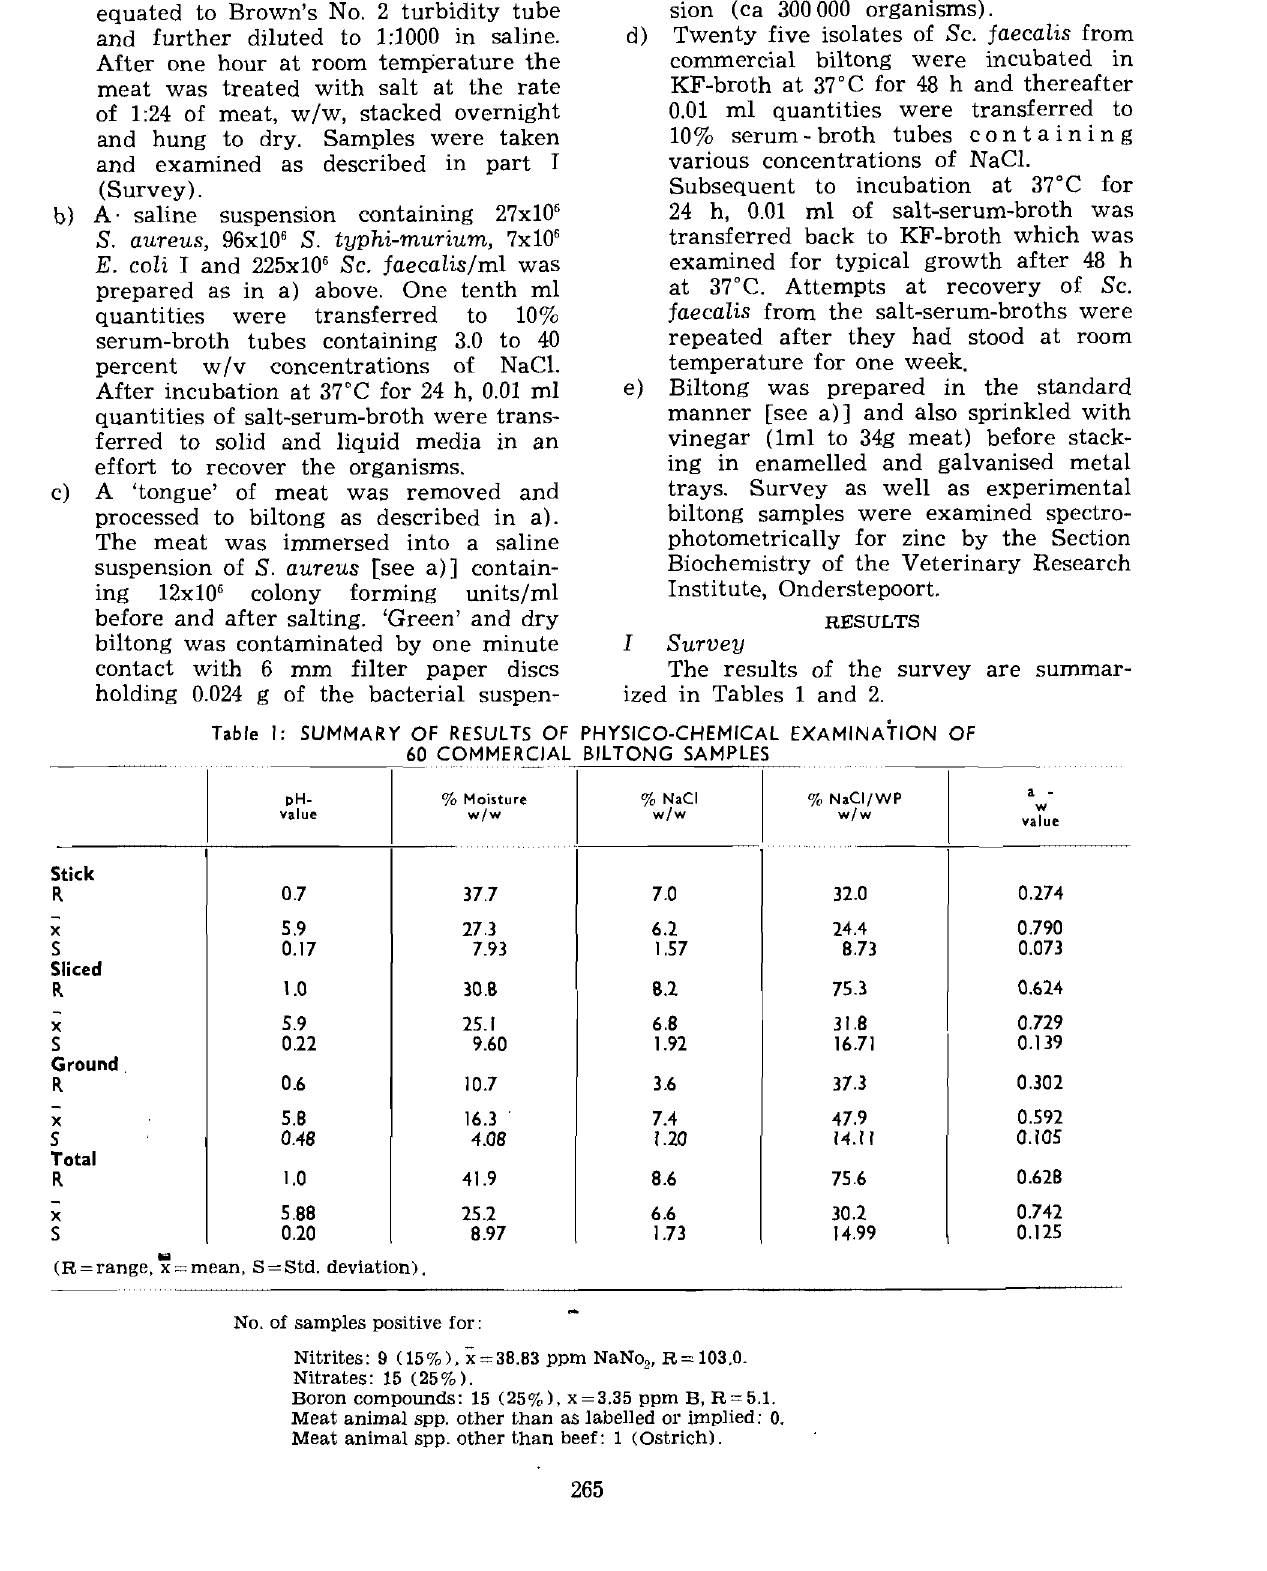
Table I: SUMMARY OF RESULTS OF PHYSICO-CHEMICAL EXAMINATION OF 60 COMMERCIAL BIL TONG